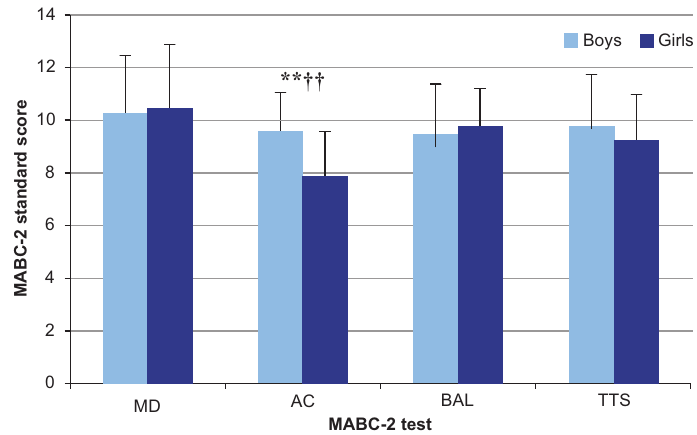
Figure 3. Comparison of the means of the three motor domains and the total test score of the MABC-2 between boys and girls. MD = manual dexterity; AC = aiming and catching; BAL = balan- ce; TTS = total test score.